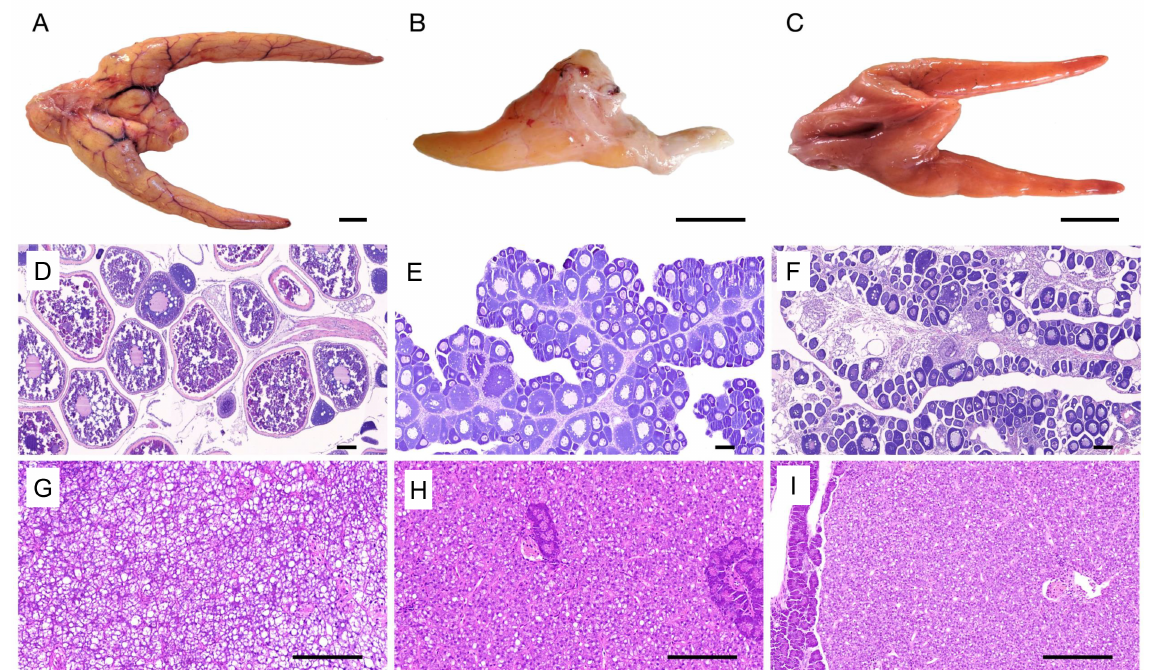
Figure 1. Morphological and histological characteristics of the ovary and liver in the fertile, infertile, and negative control Japanese flounder groups. ( A ) Morphological characteristics of the normal ovary of fertile group. ( B ) Morphological characteristics of the ovary of infertile group. ( C ) Morphological characteristics of the ovary of negative control group. ( D ) Histological characteristics of the ovary of the fertile group. ( E ) Histological characteristics of the ovary of the infertile group. ( F ) Histological characteristics of the ovary of the negative control group. ( G ) Histological characteristics of the liver in the fertile group. ( H ) Histological characteristics of the liver in the infertile group. ( I ) Histological characteristics of the liver in the negative control group. pv represents oocytes at Stage III, lv represents late vitellogenic oocytes, vs. represents vacuole structure of liver. Scale bars = 2 cm in ( A – C ), 200 µ m in ( D – F ), and 50 µ m in ( G – I